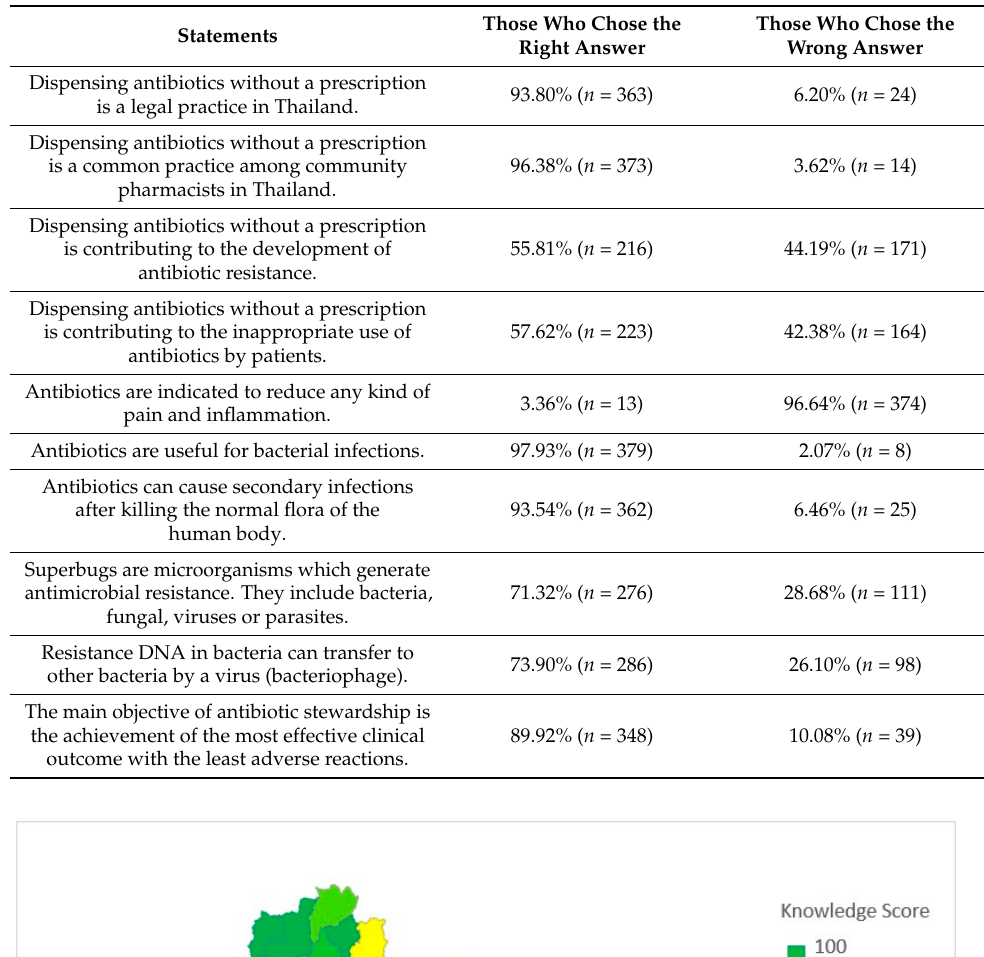
Table 2. Participants’ knowledge regarding antibiotic resistance.